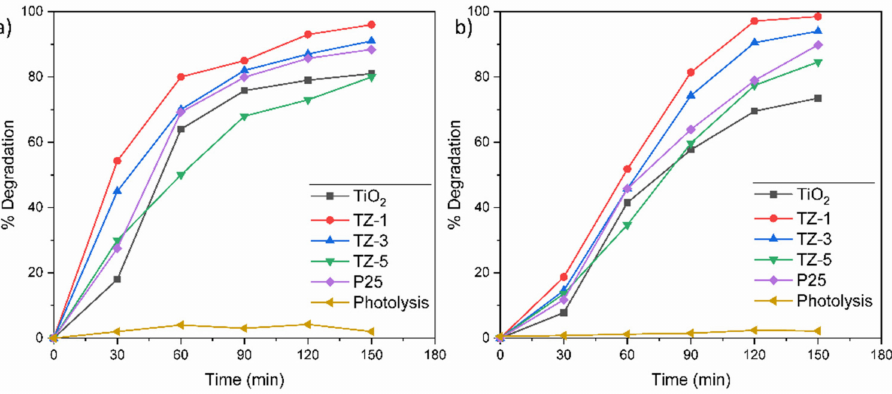
Figure 8. Degradation percentage of ( a ) RhB and ( b ) MO solutions.